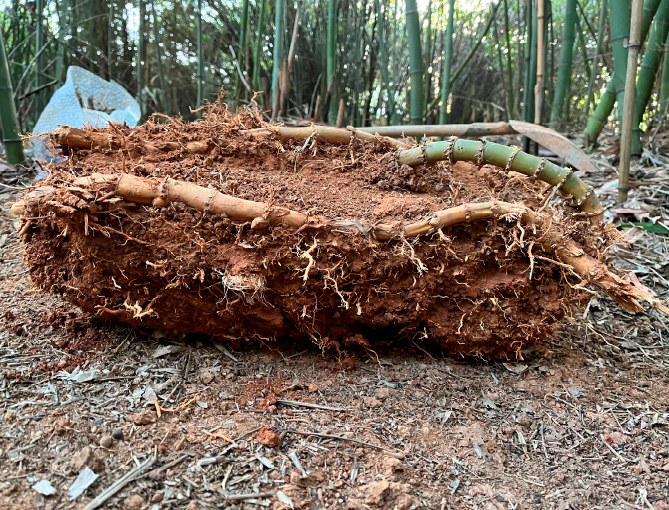
Figure 2. Morphology of the bamboo rhizomes. Table 3. Parameters of the bamboo rhizome. Table 3. Parameters of the bamboo